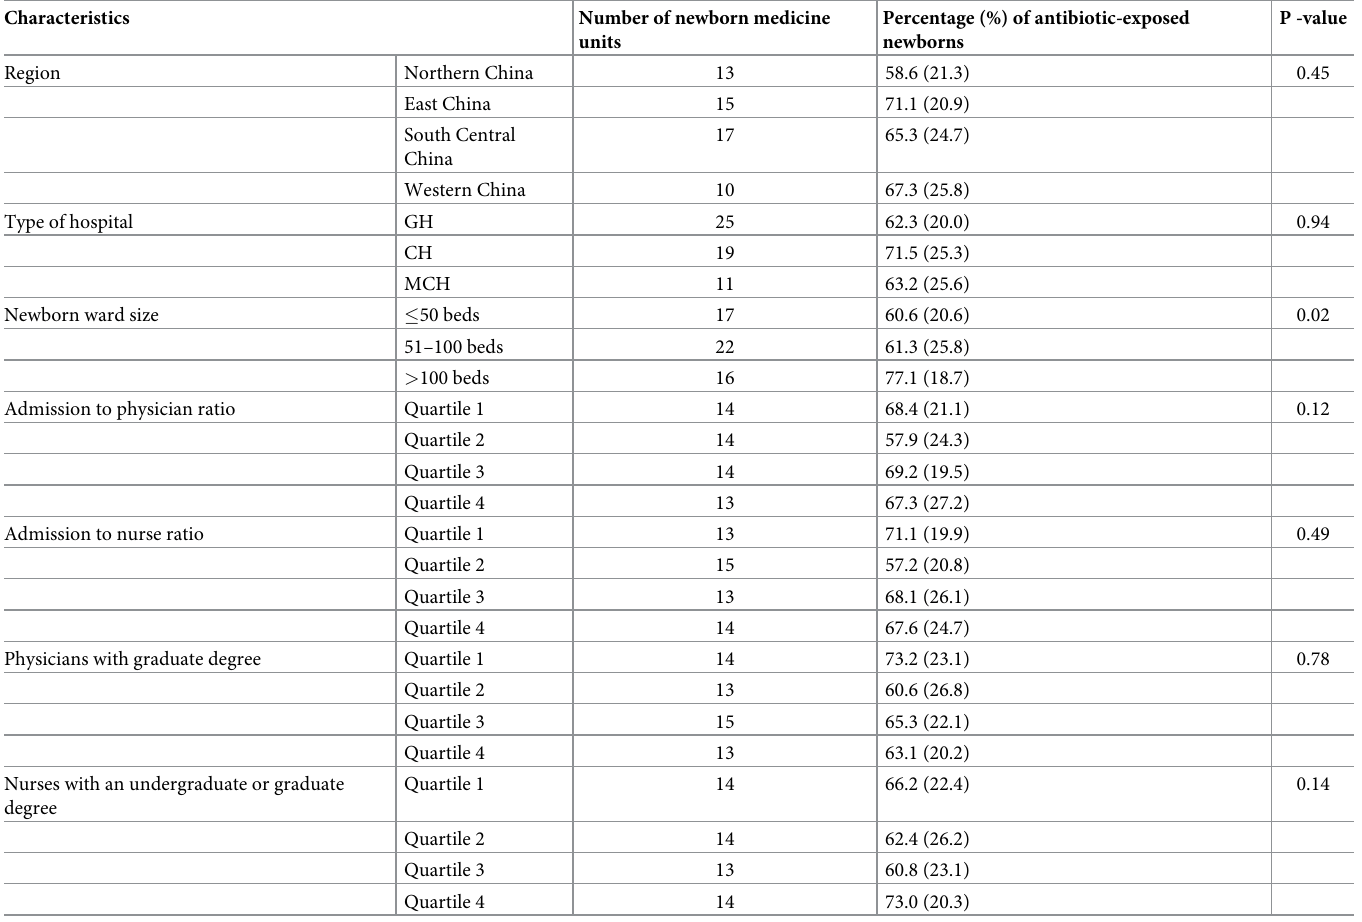
Table 2. Antibiotic use rates of inpatient newborns by classifications in